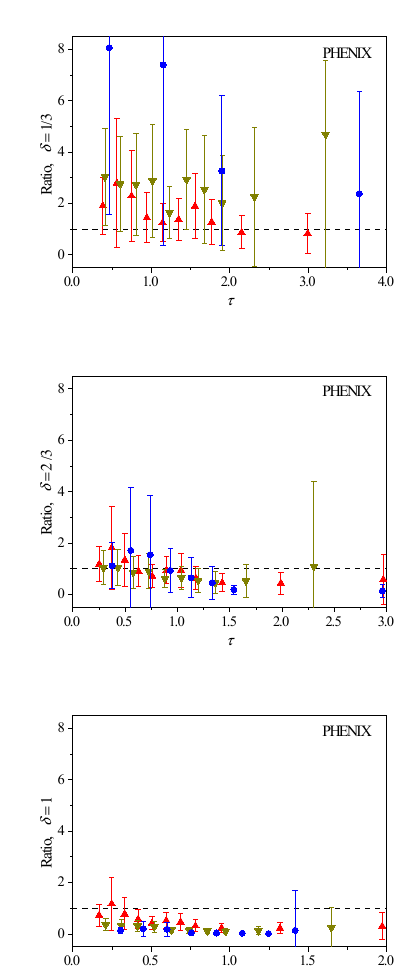
and dark-grren ones to R c . Right 1 = c 2 1 = c 3 , dark-green ones to R c and blue ones to 1 = c 2 1 = c 3